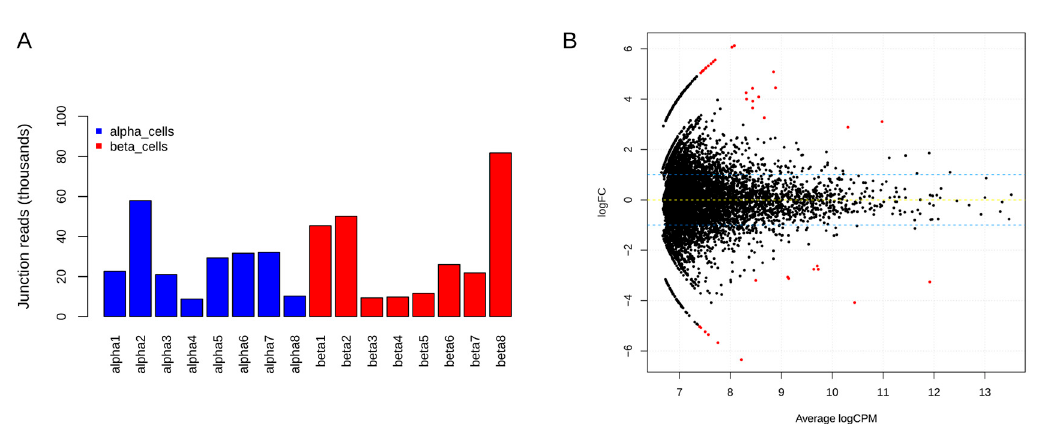
Figure 4. Distribution of junction spanning reads and smear plot of differentially expressed circRNAs. ( A ) Total circRNA junction spanning reads per sample for the high confidence circRNA candidates in α - and β -cells; ( B ) A smear plot highlighting differentially expressed candidates (as red dots) in β -cells when compared to α